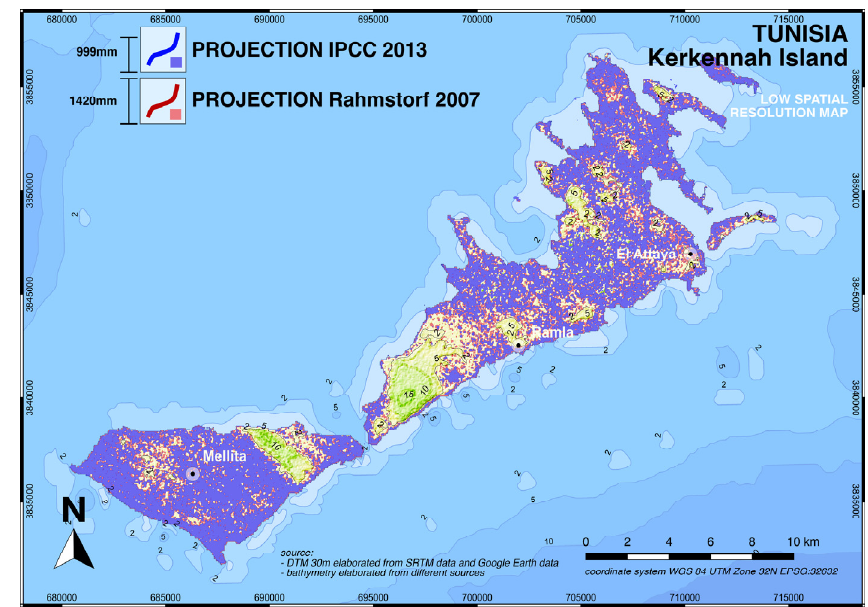
Figure 7. Map 13 Kerkennah (Tunisia), see also Figure 1 for location. The potential submersion area, using Rahmstorf 2007 projections are 109 km 2 .